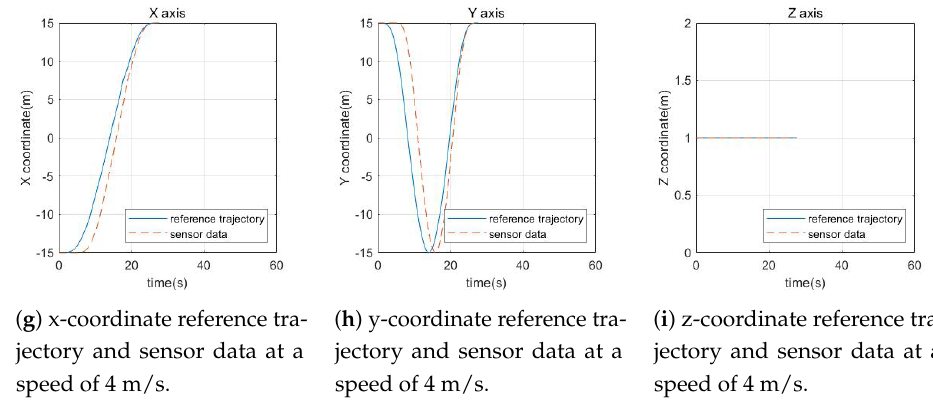
Figure 8. Reference trajectory and sensor data graph of the